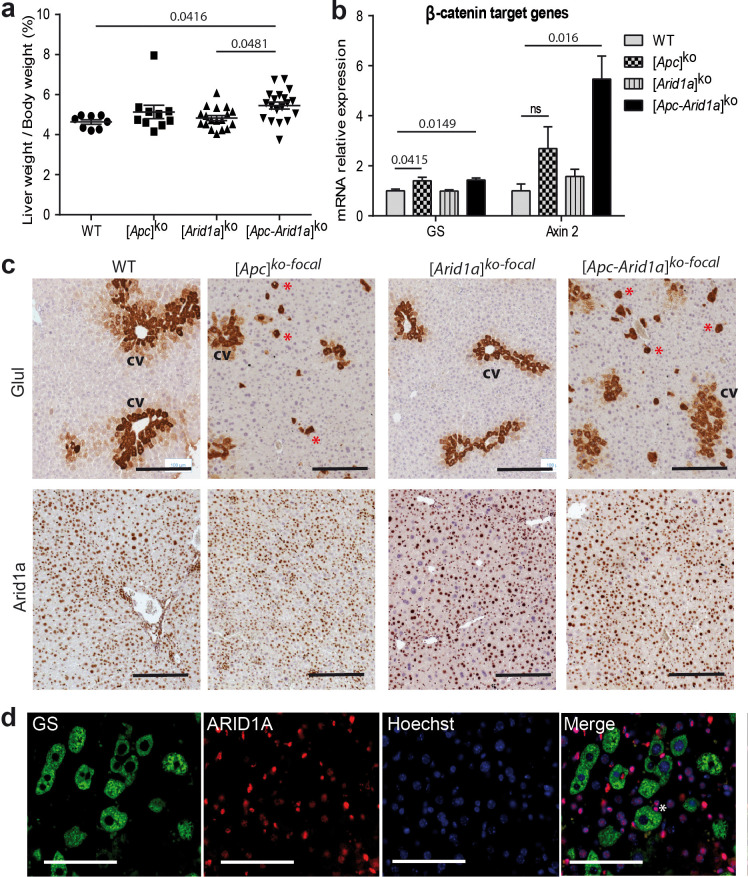
Focal inactivation of Apc and/or Arid1a genes in mouse liver.(a) Liver to Body weight (%) in mice; WT (n = 8), [Apc]ko-focal (n = 10), [Arid1a]ko-focal (n = 18), and [Apc-Arid1a]ko-focal (n = 19) mice. (b) RT-qPCR analysis of β-catenin-positive target genes from seven-month-old-mouse livers. WT (n = 5), [Apc]ko-TOTAL (n = 7), [Arid1a]ko-TOTAL (n = 12), and [Apc-Arid1a]ko-TOTAL (n = 10) mice. The data in (a,b) are expressed as the mean ± SEM and analyzed with one-way ANOVA. (c,d) Immunostainings against glutamine synthetase (Glul) and Arid1a after focal Apc and/or Arid1a loss. (c) Note the physiological staining of Glul in hepatocytes surrounding the centrolobular vein (cv). Focal activation of β-catenin signaling in single hepatocytes leads to an immunostaining of Glul, its hepatospecific target (red asterisk). Scale bars = 200 μm. (d) Immunofluorescence for Glul in hepatocytes without Arid1a nuclear fluorescence (white asterisk), shows the efficiency and specificity of the double Apc/Arid1a inactivation in [Apc-Arid1a]ko-focal livers (white asterisk). Scale bars = 100 μm.Figure 1—figure supplement 1—source data 1.Liver to body weight ratios (Figure 1—figure supplements 1a) and expression of Glul and Axin2 mRNAs (Figure 1—figure supplements 1b).